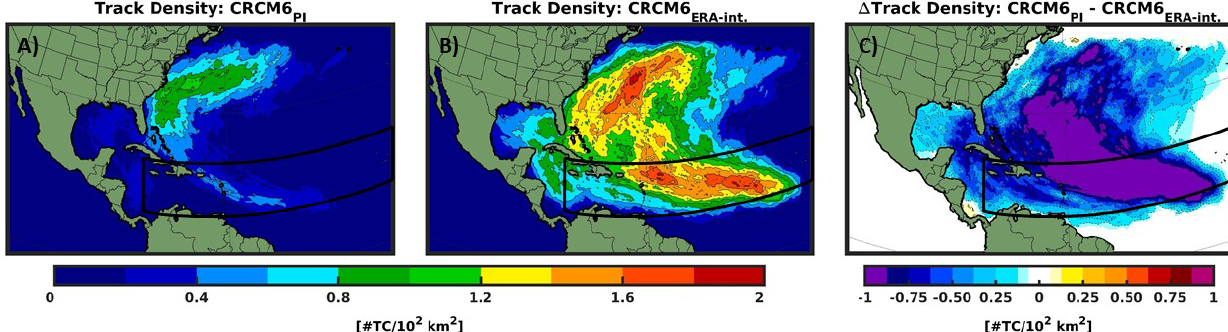
Figure A2. Climatological track density (JJASON) for the (a) pre-industrial experiment at 0.22 ◦ and (b) ERA-Interim-driven experiment at 0.22 ◦ . (c) Changes in track density between the two simulations. The black box shows the approximate present-day MDR. Only values that are significantly different at the 5% level using a local (grid-point) t test are shaded. The contour lines follow the color-bar scale (dashed, negative anomalies; solid, positive anomalies); the 0 line is omitted for